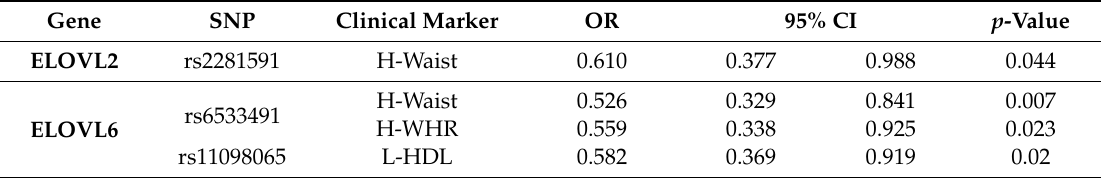
Table 7. Association of SNPs with clinical markers of chronic non-communicable diseases in women (protective factors). Gene